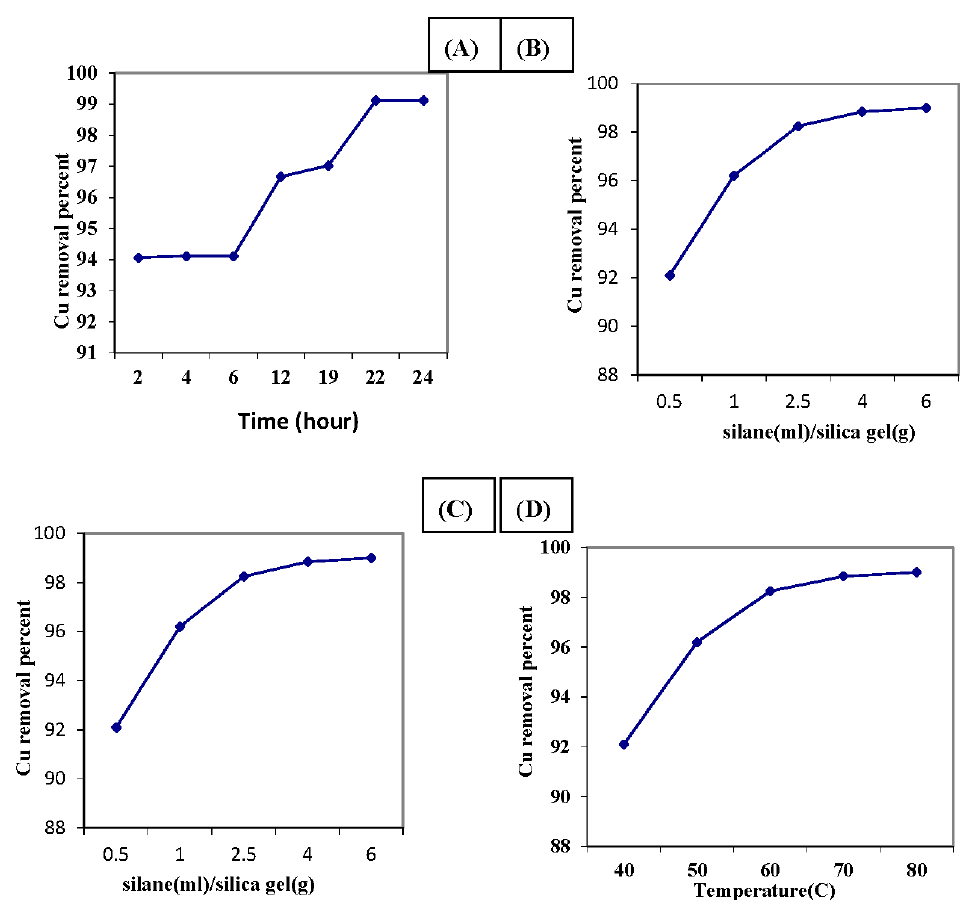
Figure 2. Effect of chemical modification parameters on amine-functionalized silica gel copper sorption capacity. ( A ) Effect of reaction time; ( B ) effect of the variation of the solvent to silica gel ratio; ( C ) effect of the variation of the propyl triethoxy silane (APTS) to silica gel ratio; ( D ) effect of the reaction temperature. Solution concentration of copper ion = 100 ppm; amount of ANSG = 0.2 g; agitation time = 90 min; agitation speed = 200 rpm; solution volume = 25 mL; pH = 7.